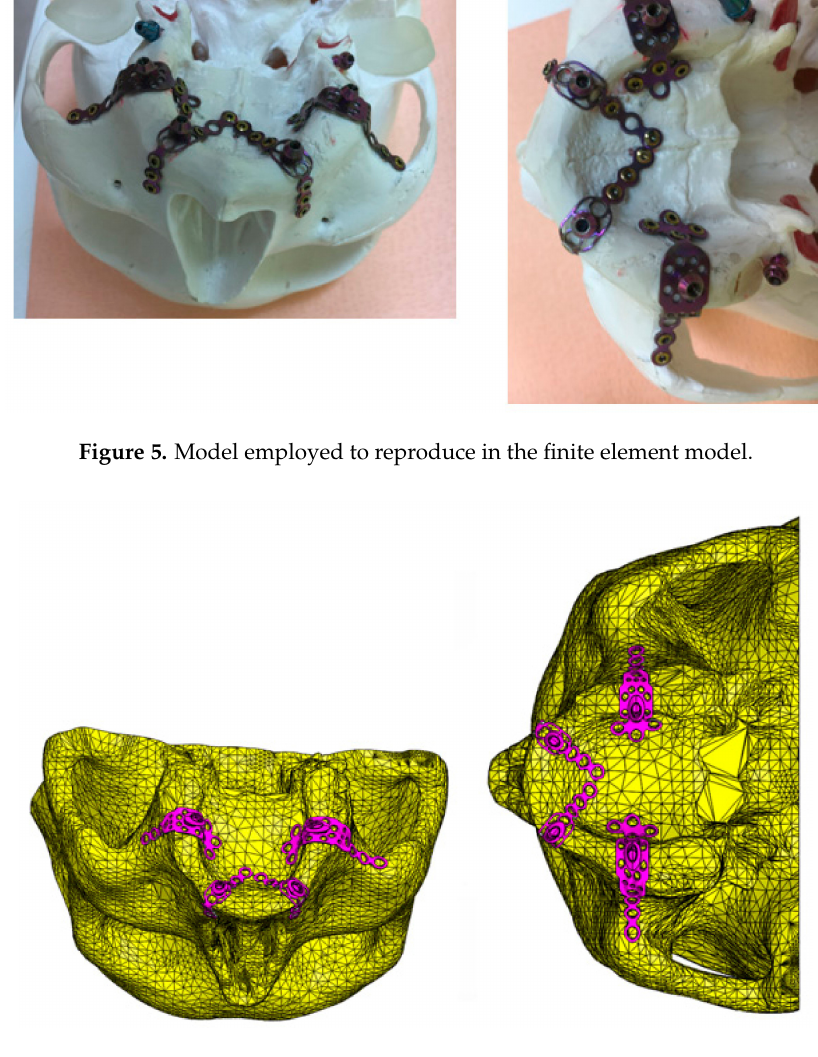
Figure 6. Finite element model employed in this study.